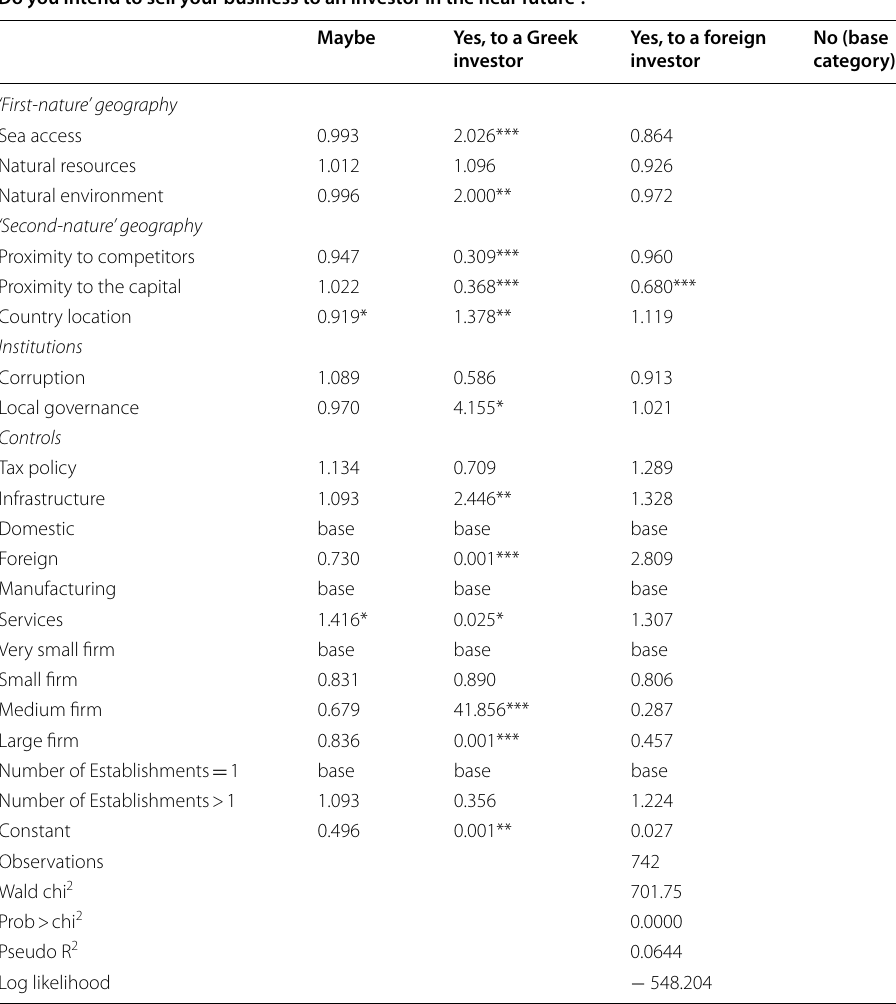
Table 4 Multinomial logistic regression results for business